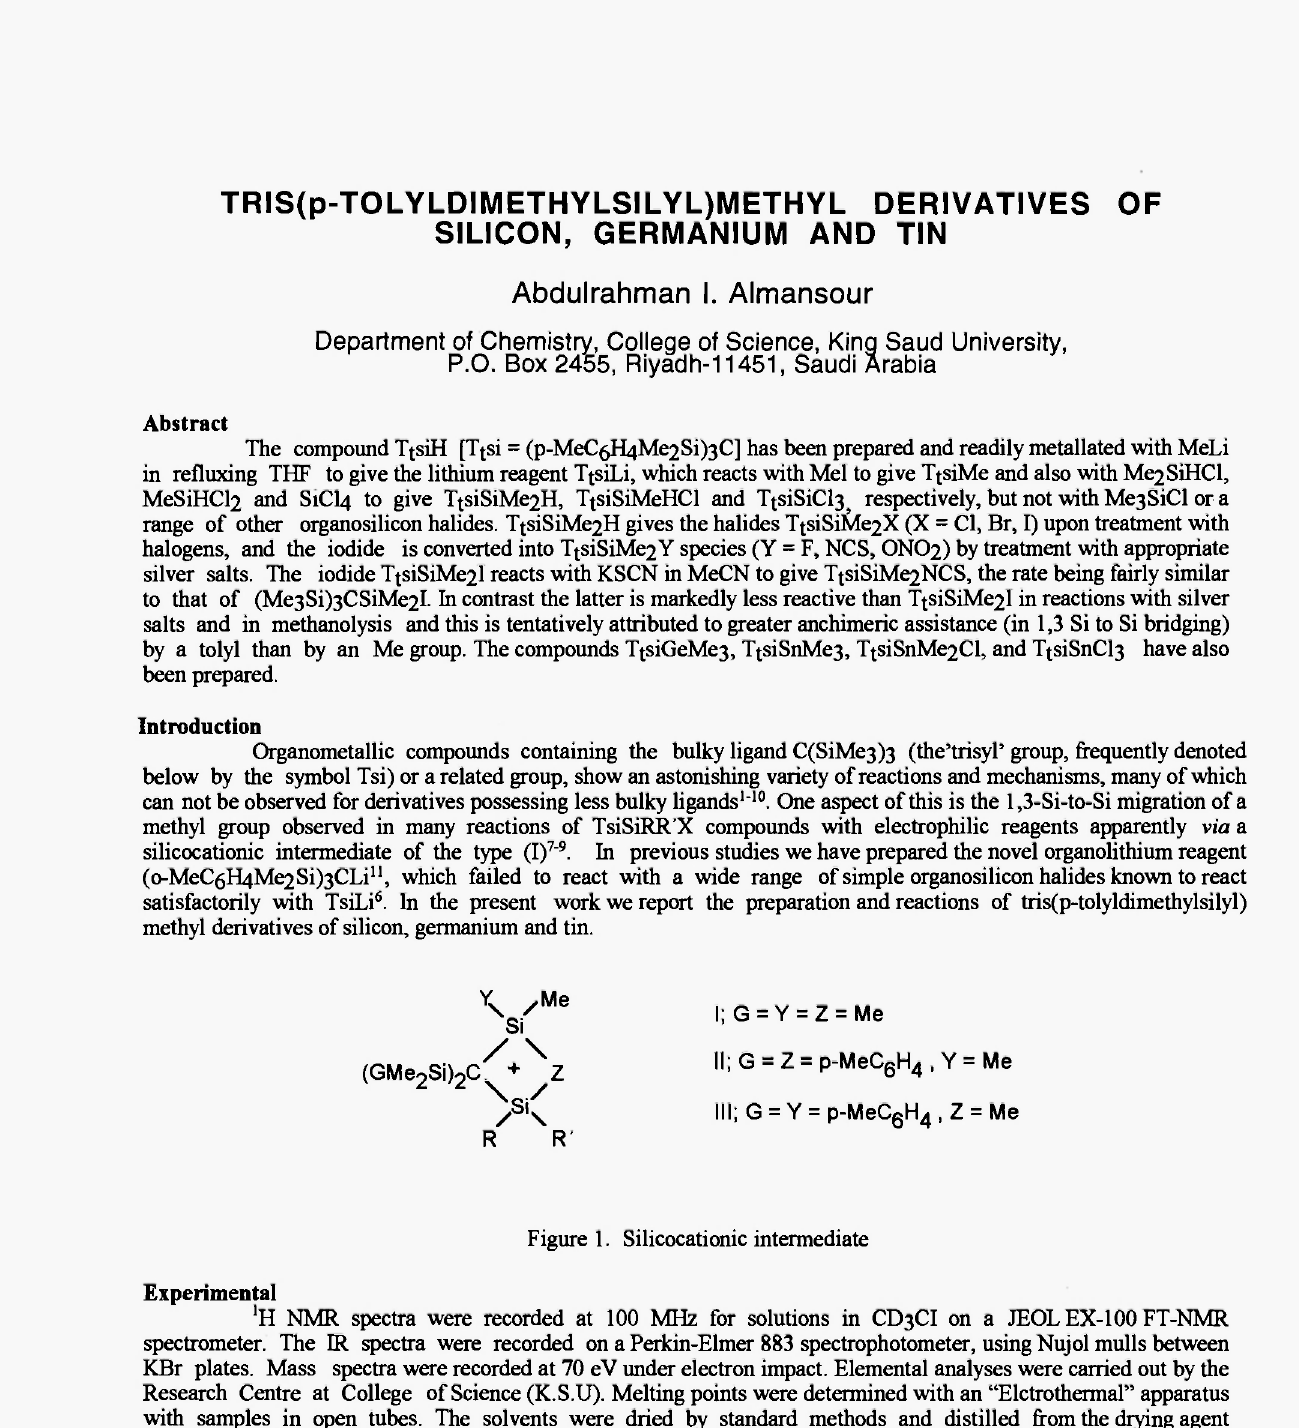
Figure 1. Silicocationic